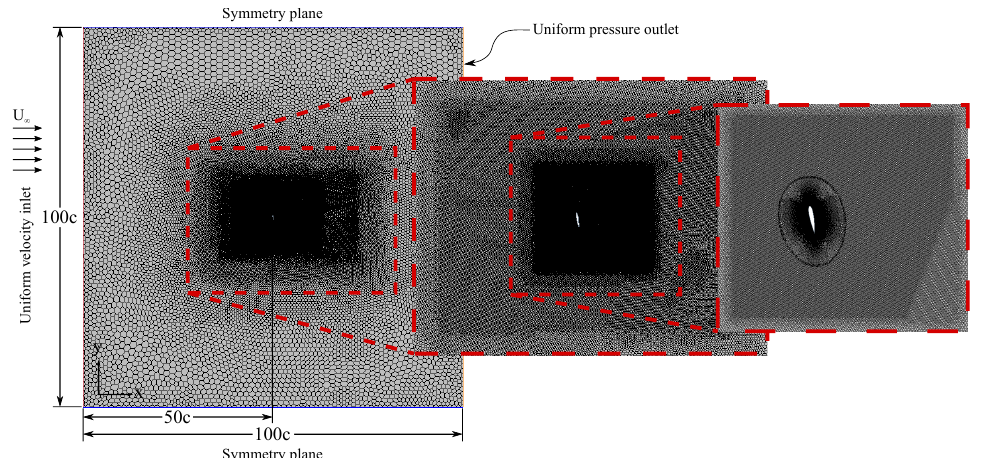
Figure 4. Mesh and domain specifications, including boundary